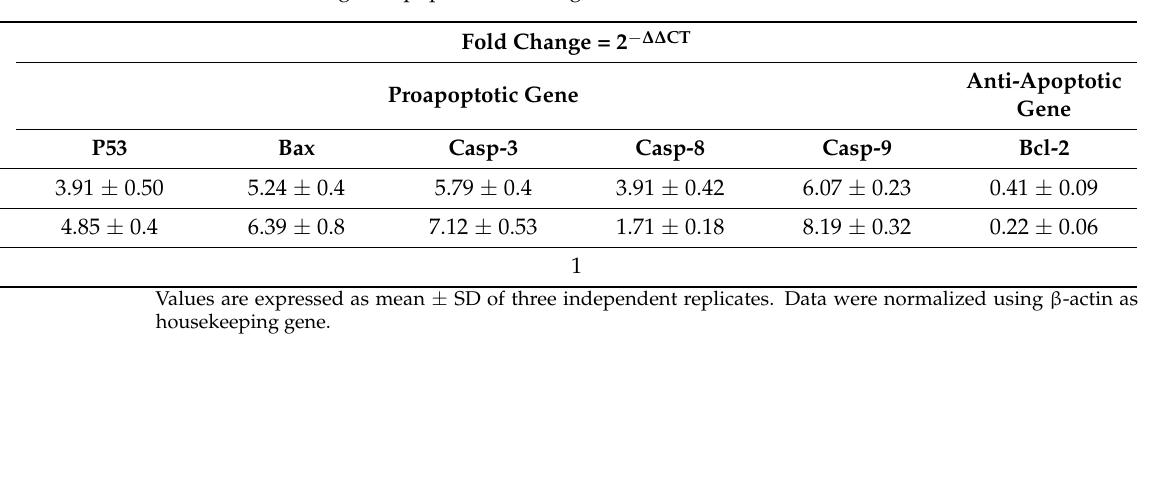
Table 3. Fold change of apoptosis-related genes in untreated and treated MCF-7